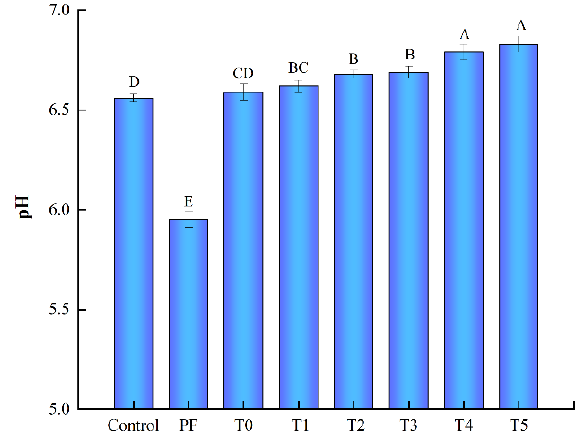
Figure 1. pH values of phosphate-containing frankfurters or phosphate-free frankfurters added with the combination of L-Arginine (L-Arg) and potassium carbonate (PC). The different uppercase letters (A–E) represent statistically significant differences for the different samples ( p < 0.05). PF group: no added phosphate. T0 group: 0.15% PC and no added phosphate. T1 group: 0.15% PC + 0.025% L-Arg, and no added phosphate. T2 group: 0.15% PC + 0.05% L-Arg, and no added phosphate. T3 group: 0.15% PC + 0.075% L-Arg, and no added phosphate. T4 group: 0.15% PC + 0.1% L-Arg, and no added phosphate. T5 group: 0.15% PC + 0.125% L-Arg, and no added phosphate.